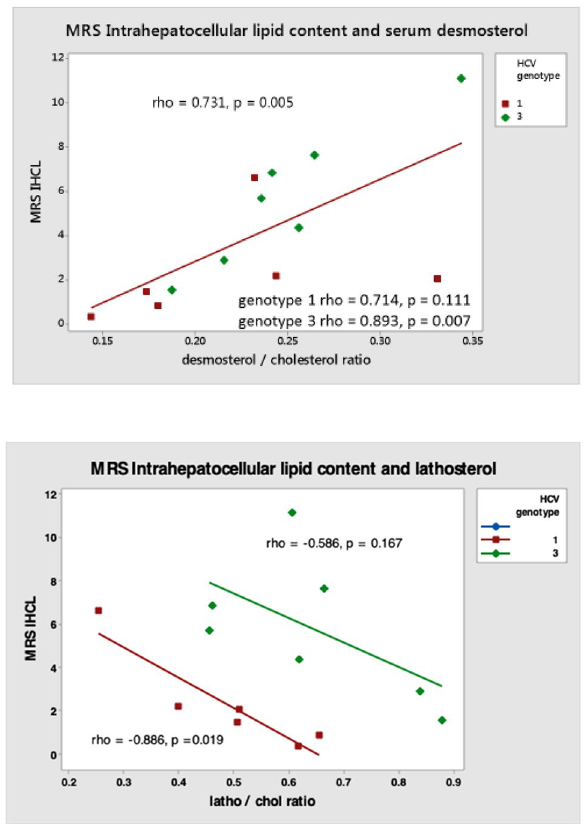
Figure 2. Correlation between intra-hepatocellular lipid content (steatosis) and fasting serum markers of endogenous cholesterol synthesis lathosterol and desmosterol in HCV genotypes 1 (N = 6) and 3 (N =